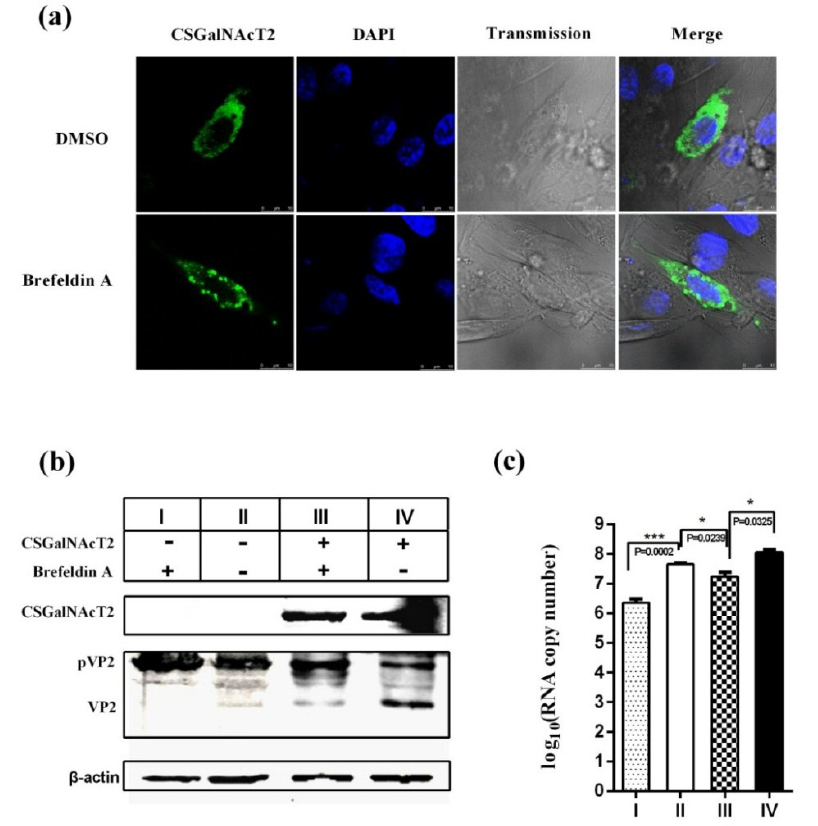
Figure 6. The integrity of the Golgi apparatus is involved in the effect of CSGalNAcT2 on IBDV replication. ( a ) To confirm the effect of Brefeldin A on the Golgi apparatus and the location of the exogenous CSGalNAcT2, DF1 cells transfected with CSGalNAcT2 were treated with Brefeldin A or DMSO for 48 h. Then, cells were fixed and permeabilized for immunofluorescence assay. The location of CSGalNAcT2 is indicated by FITC (green) and the whole cellular morphology is shown under transmission conditions. DAPI (blue) stains the cell nucleus. The exogenously expressed CSGalNAcT2 was dispersed